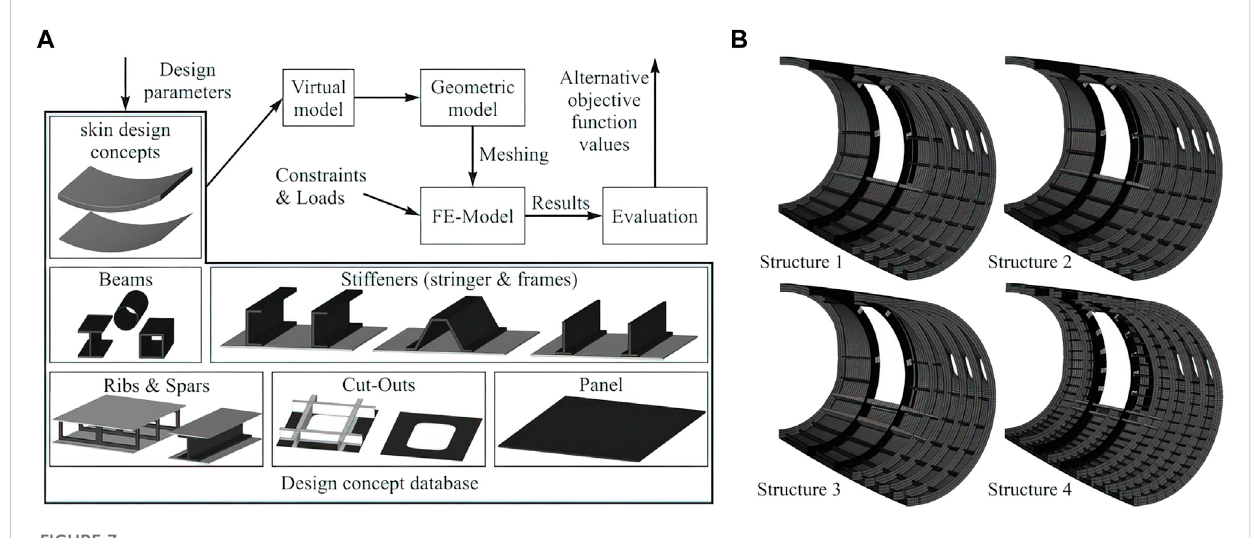
FIGURE 7 (A) Flowchartof thesimulation model including the design concept database, (B) theoptimization ofCFRP composite fuselage tail sections (Seeger and Wolf,